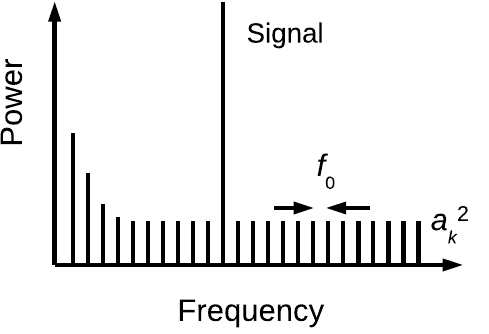
Figure 7. A model of the phase noise source based on uniformly distributed